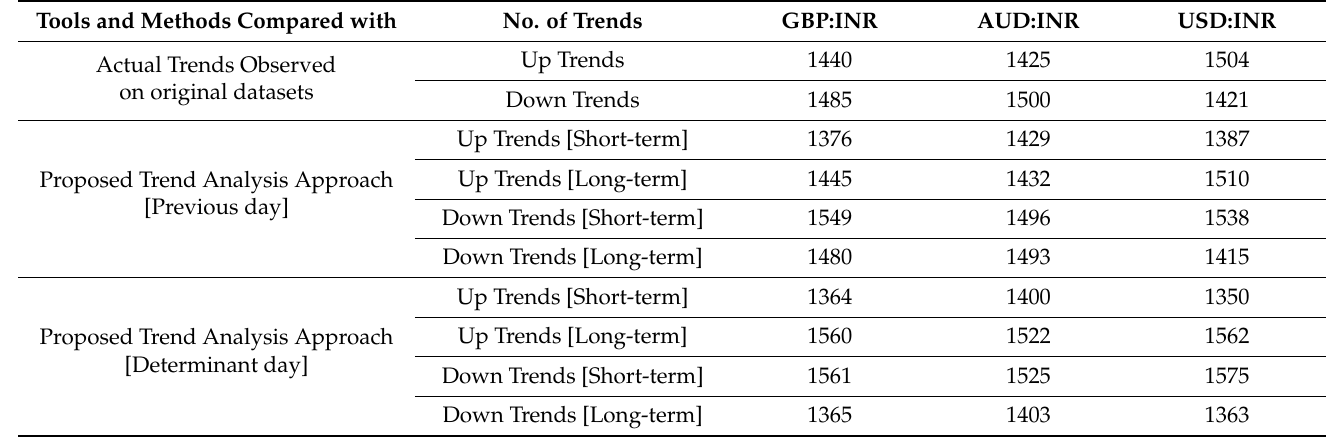
Table 7. Number of up trends and down trends observed for three currency pairs. Tools and Methods Compared